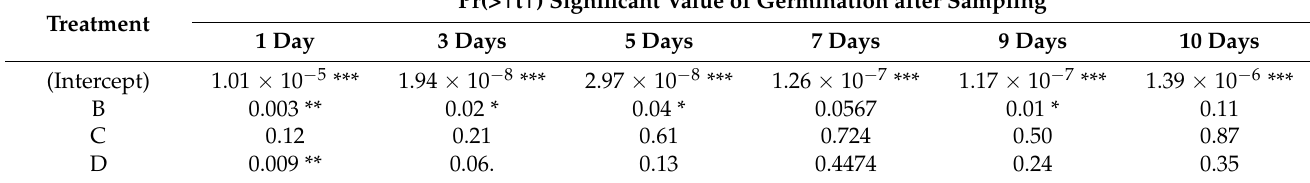
Figure 10. Plant germination and development of plants from seeds with different treatments: ( A ) control; ( B ) primed; ( C ) pelleted and coated; and ( D ) primed, pelleted, and coated; from sowing to 15 days after sowing. The Y -axis represents the digital biomass in pixels and the X -axis represents sampling days. Table 4. p -Value analysis of the plant germination rate of plants’ seeds with different treatments: ( A ) control (intercept); ( B ) primed; ( C ) pelleted and coated; and ( D ) primed, pelleted, and coated; during the different days sampled. Significant differences marked with asterisk (* p < 0.05, ** p < 0.01 and *** p < 0.001). Pr(>|t|) Significant Value of Germination after Treatment